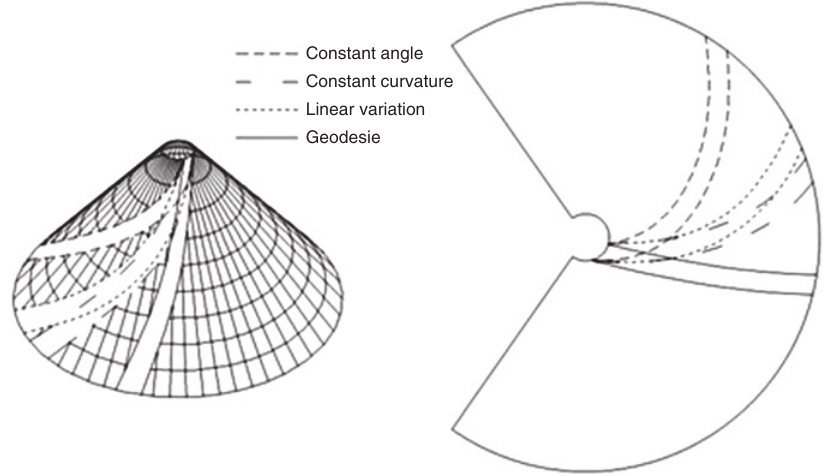
Figure 6: Different fiber paths for conical